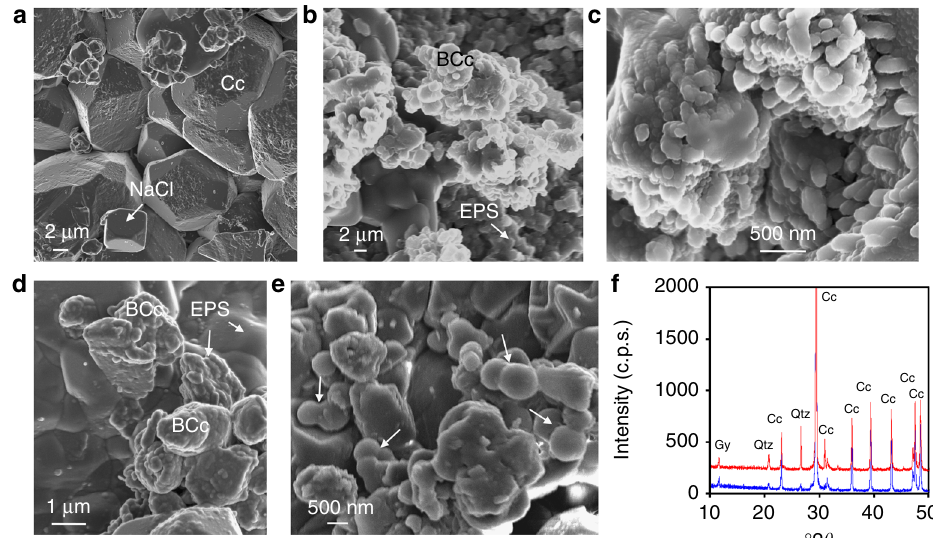
Fig. 6 Analysis of in situ bio-treated calcarenite stone. SEM images of untreated calcarenite ( a ) and calcarenite treated with the bacterial community ( b – e ). a Micrometer-sized calcite (Cc) crystals in the control stone show dissolution pits and are covered by salt (e.g., NaCl) crystals; b bacterial calcite (BCc) cement shows nanogranular structure surrounded by EPS; c detail of the nanogranular structure of calcite biocement interspersed with EPS; d bacterial calcite and abundant EPS covering the calcarenite substrate; e detail of mineralized bacterial cells ( arrows ); f XRD patterns of calcarenite before ( blue ) and after ( red ) bacterial bio-treatment. Cc, calcite; Gy, gypsum; Qtz,